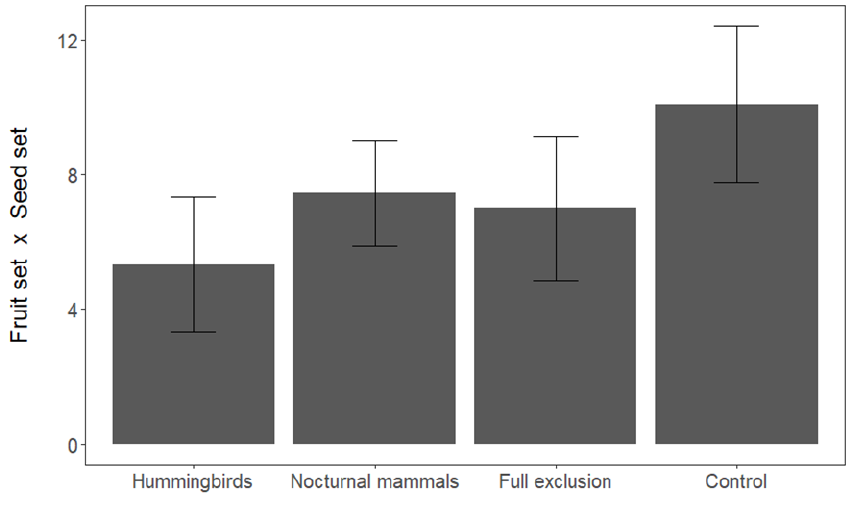
Values depicted are mean ± SE. Different letters above the SE bars indicate statistical